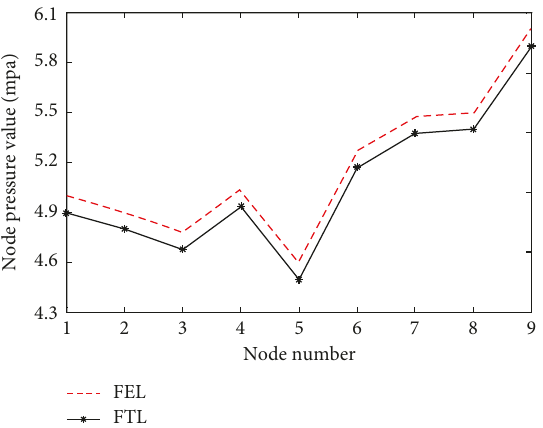
Figure 4: Pressure of each node in different modes.